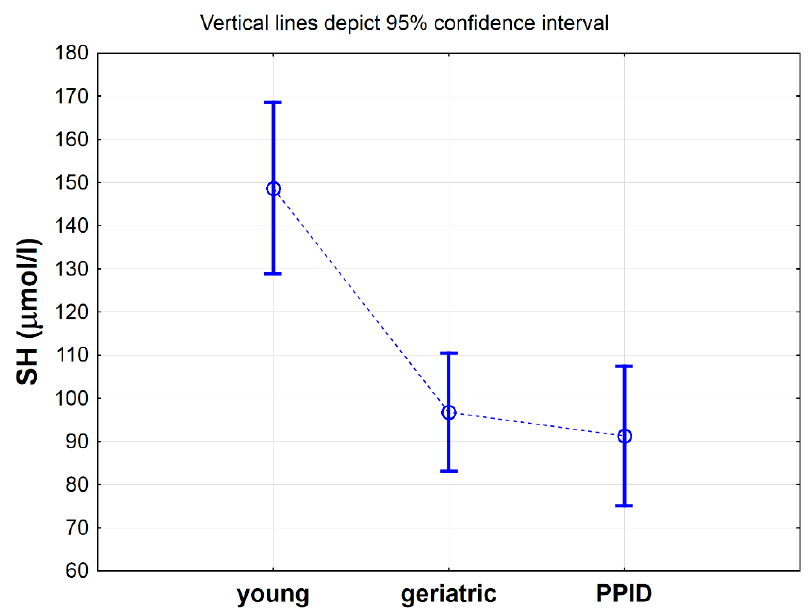
Figure 1. Mean values of total thiol -SH concentration measured in serum of horses in young, geriatric and pituitary pars intermedia dysfunction (PPID) group. Statistical significance was set at p < 0.05. The statistical significance difference between young group vs. geriatric and PPID groups was shown.